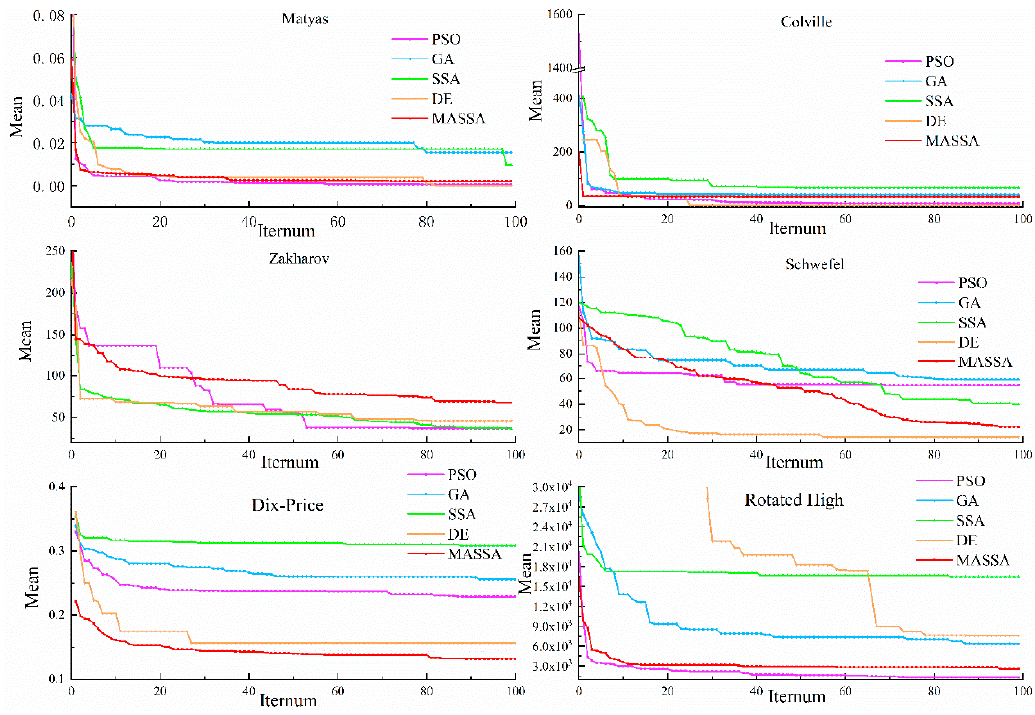
Figure 4. Convergence results 2 of unimodal benchmark functions. Table 6. Result of multimodal benchmark functions.